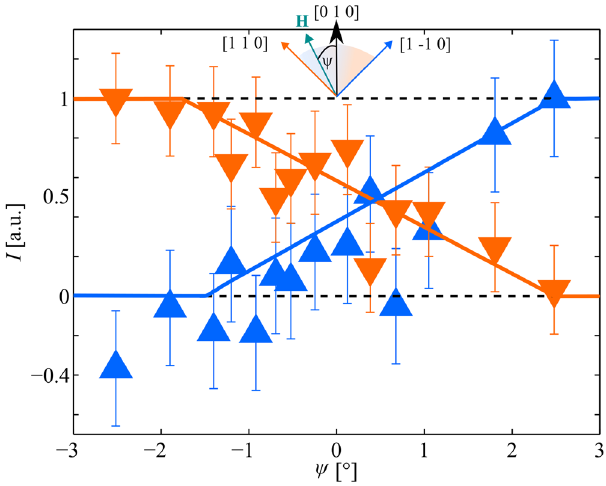
Figure 2. Domain population. Background subtracted peak intensity as a function of ψ for representatives of Q 2 in orange and Q 1 in blue measured at μ 0 H = 10.4 T. Solid lines are guide lines to the eyes. Dashed line represent the fully suppressed and fully populated